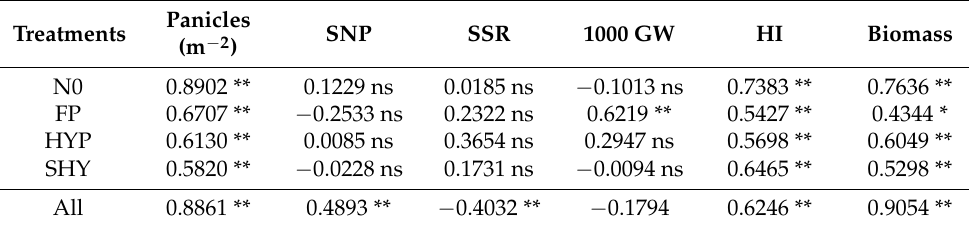
Table 4. Correlation coefficient between theoretical yield, yield components, harvest index, and